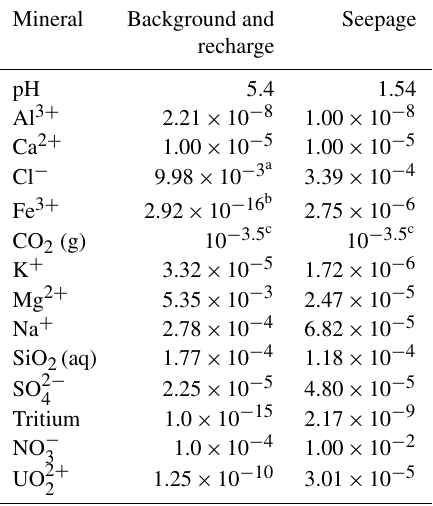
Table 2. Chemical composition for the background (initial), recharge and seepage solutions (modified from Bea et al., 2013). Unit is molkgw − 1 , except pH and CO 2 (aq).